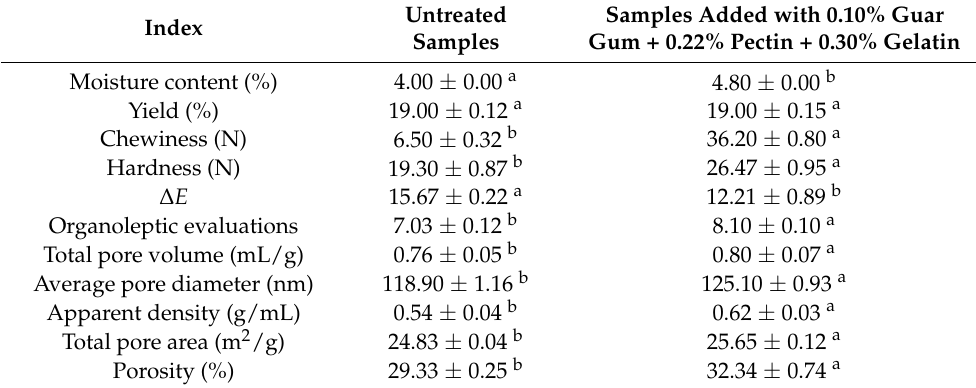
Table 2. Comparison of indices for the untreated and treatment samples of the freeze-dried restruc- tured strawberry